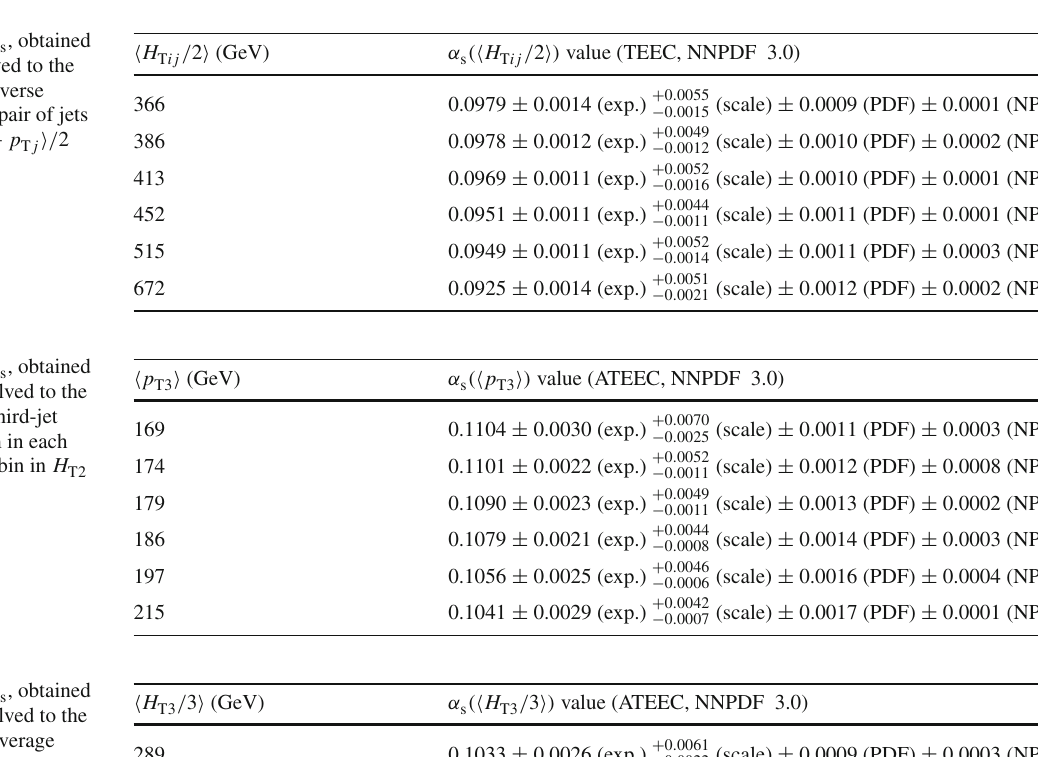
Table 9 Values of α s , obtained from TEEC fits, evolved to the average value of the average transverse momentum of the three leading jets in each event, (cid:4) ( p + p + p ) (cid:5) / 3 for each T1 T2 T3 bin in H T2